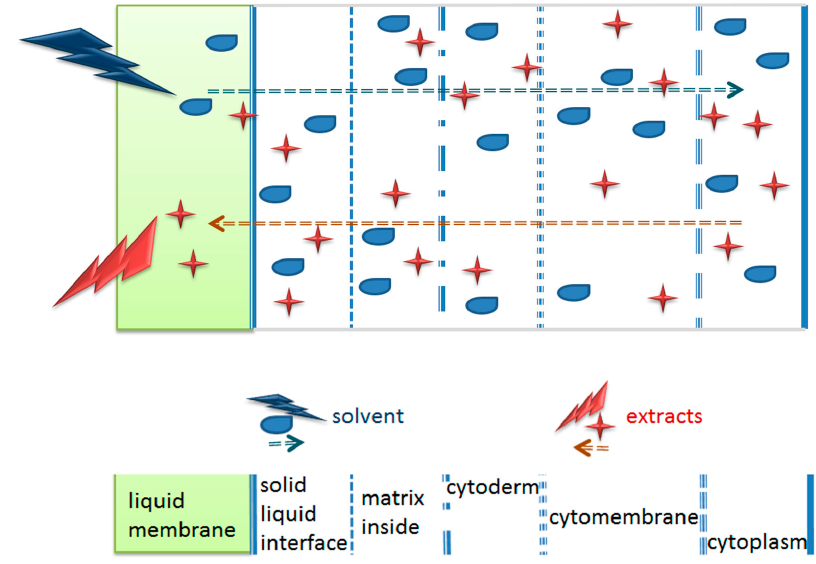
Figure 3. Unstable and non-equilibrium diffusion model of the target component intracellular